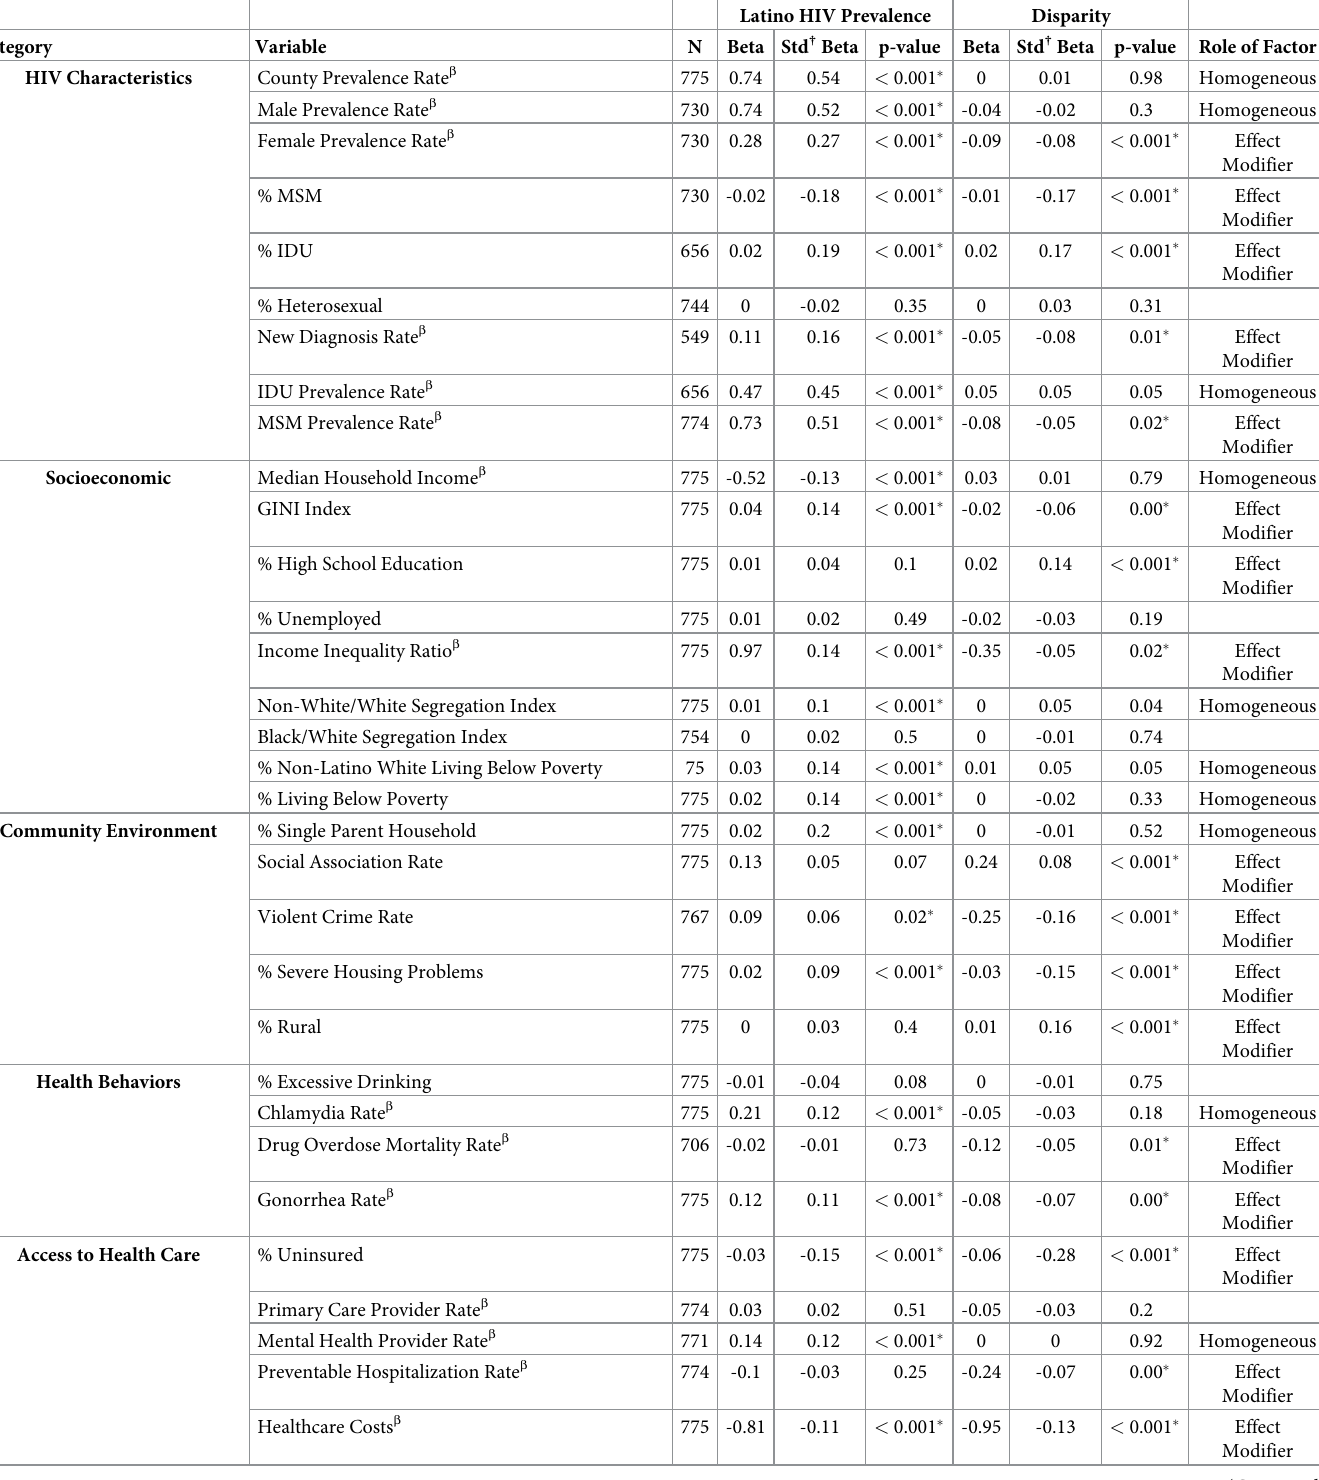
Table 1. Individual covariate impact on Latino prevalence and disparities (maximum N = 775